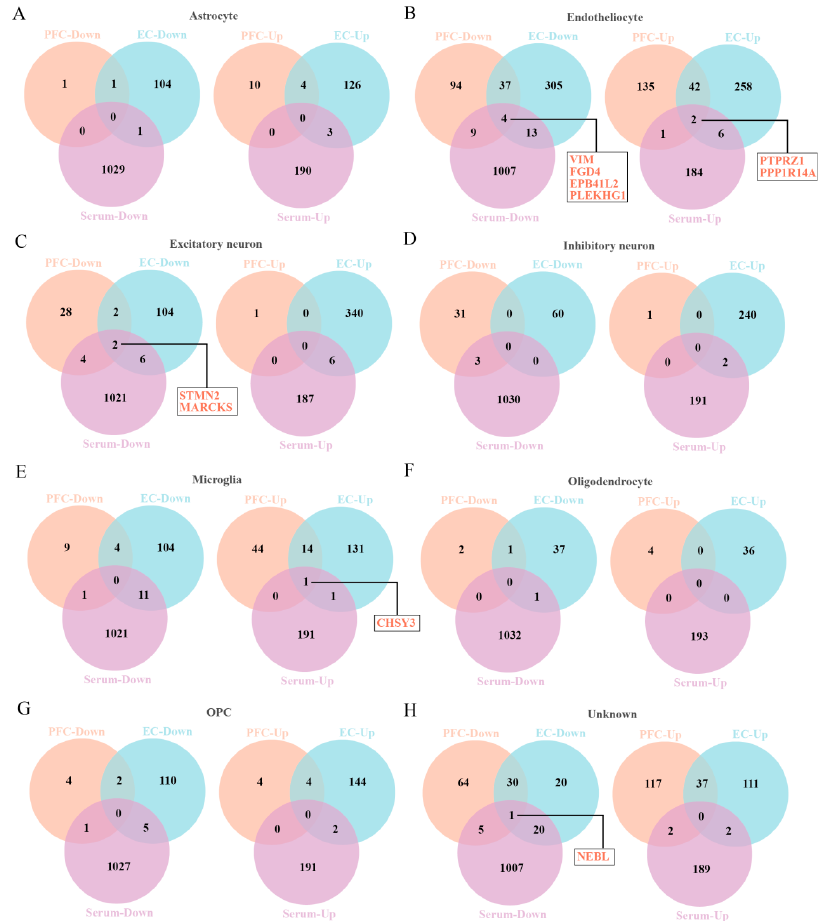
(Figure 2), including NEBL, CHSY3, STMN2, MARCKS, VIM, FGD4, EPB41L2, PLEKHG1, PTPRZ1, and PPP1R14A (Table 2).